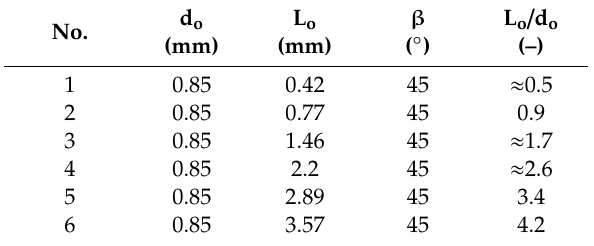
Table 3. The tested exit orifices geometry: exit orifice diameter (d o ) and length (L o ).